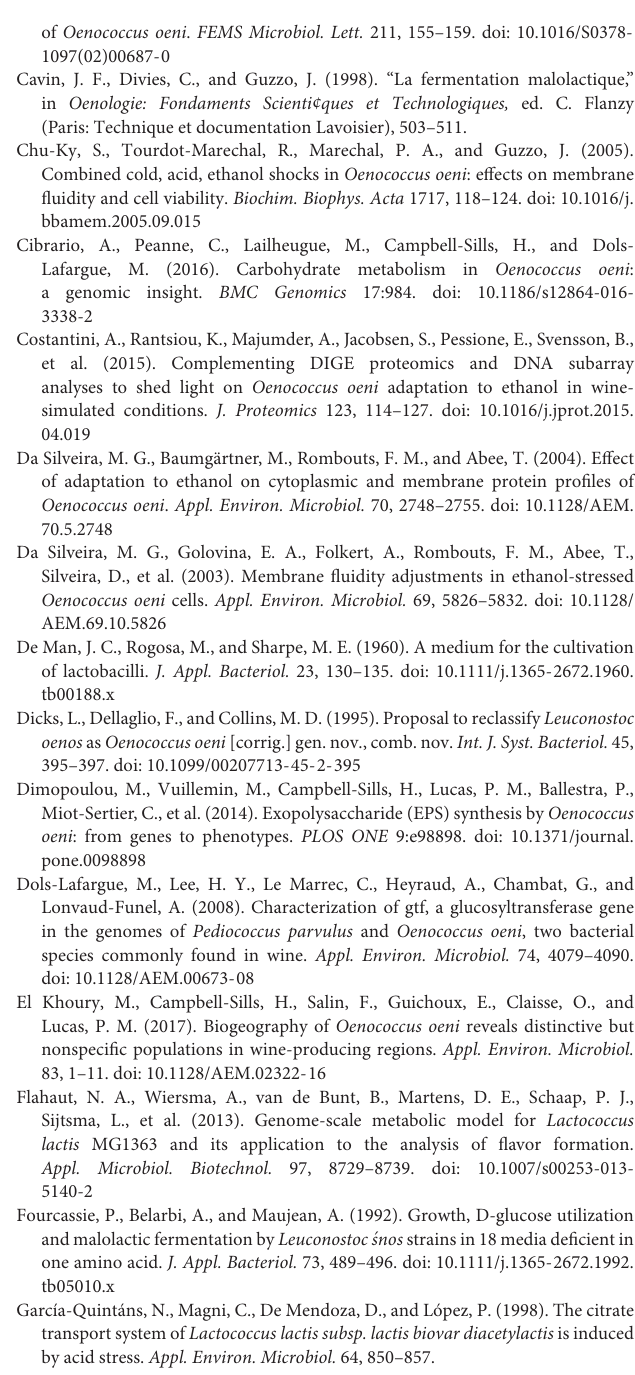
3, 6, 9, and 12% (orange boxes, from top to bottom) ethanol concentration, during growth phase III. FILE S1 | Reactions contained in the reduced version of the iSM454 model. FILE S2 | Sensitivity analysis of NGAM estimation with respect to the fixed specific consumption/production rates of compounds during growth of O.oeni PSU-1 at different ethanol concentrations in maxOeno